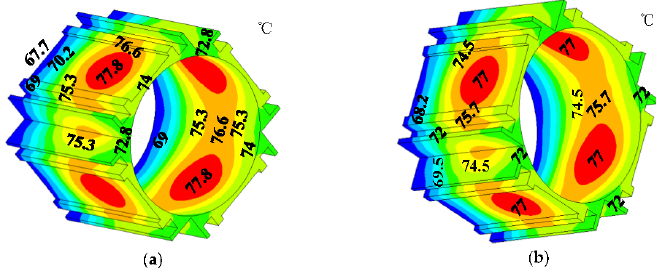
Figure 6 . Temperature distribution of frame before and after the applying the proposed permanent magnet local maximum temperature suppressing method: ( a ) Temperature distribution of frame before the applying the proposed permanent magnet local maximum temperature suppressing method; ( b )Temperature distribution of frame after the applying the proposed permanent magnet local maximum temperature suppressing method.